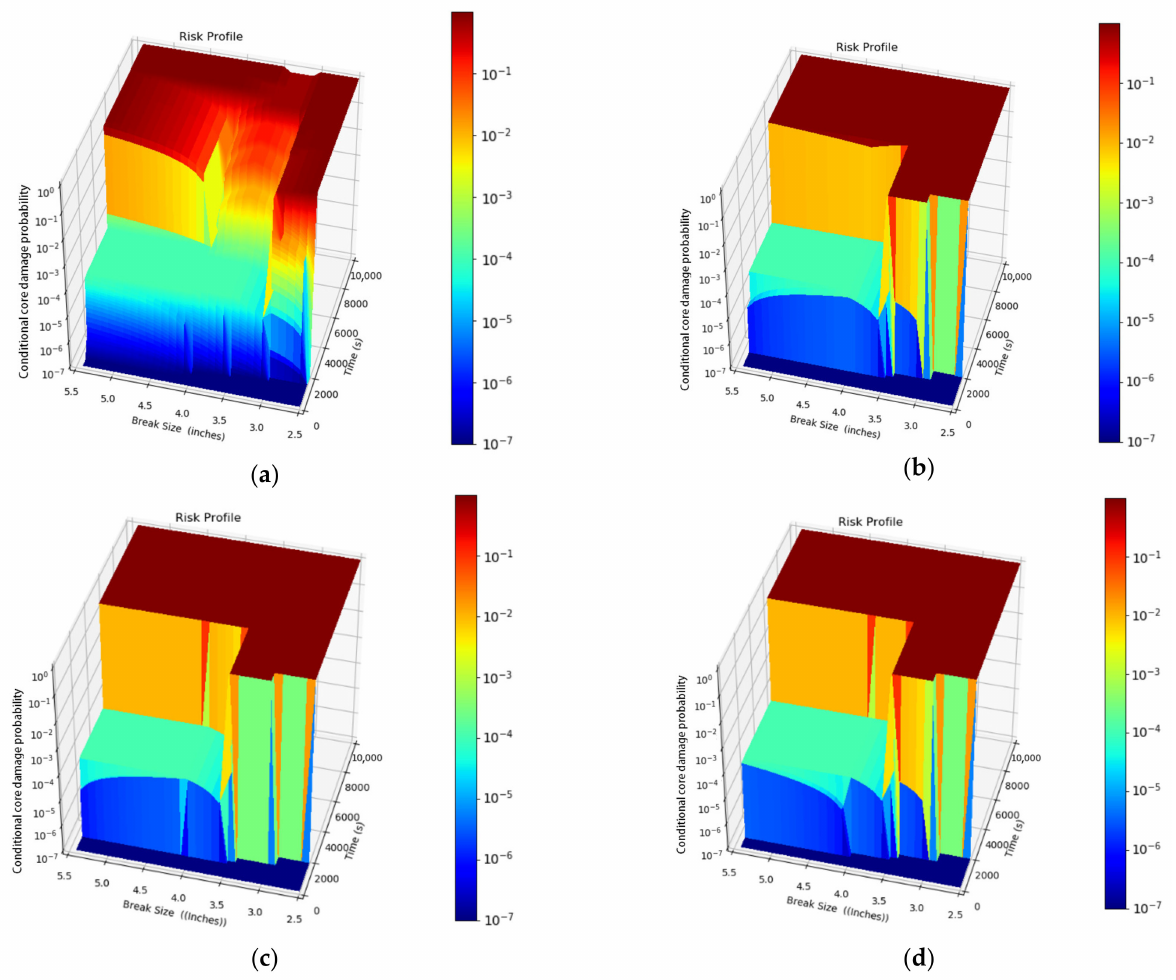
Figure 9. Core damage timings for ATF fuel types: ( a ) Multi-layered SiC; ( b ) Iron-clad (FeCrAl); ( c ) Conventional Zircaloy (Zr); ( d ) Chromium-coated Zircaloy (Cr-coated